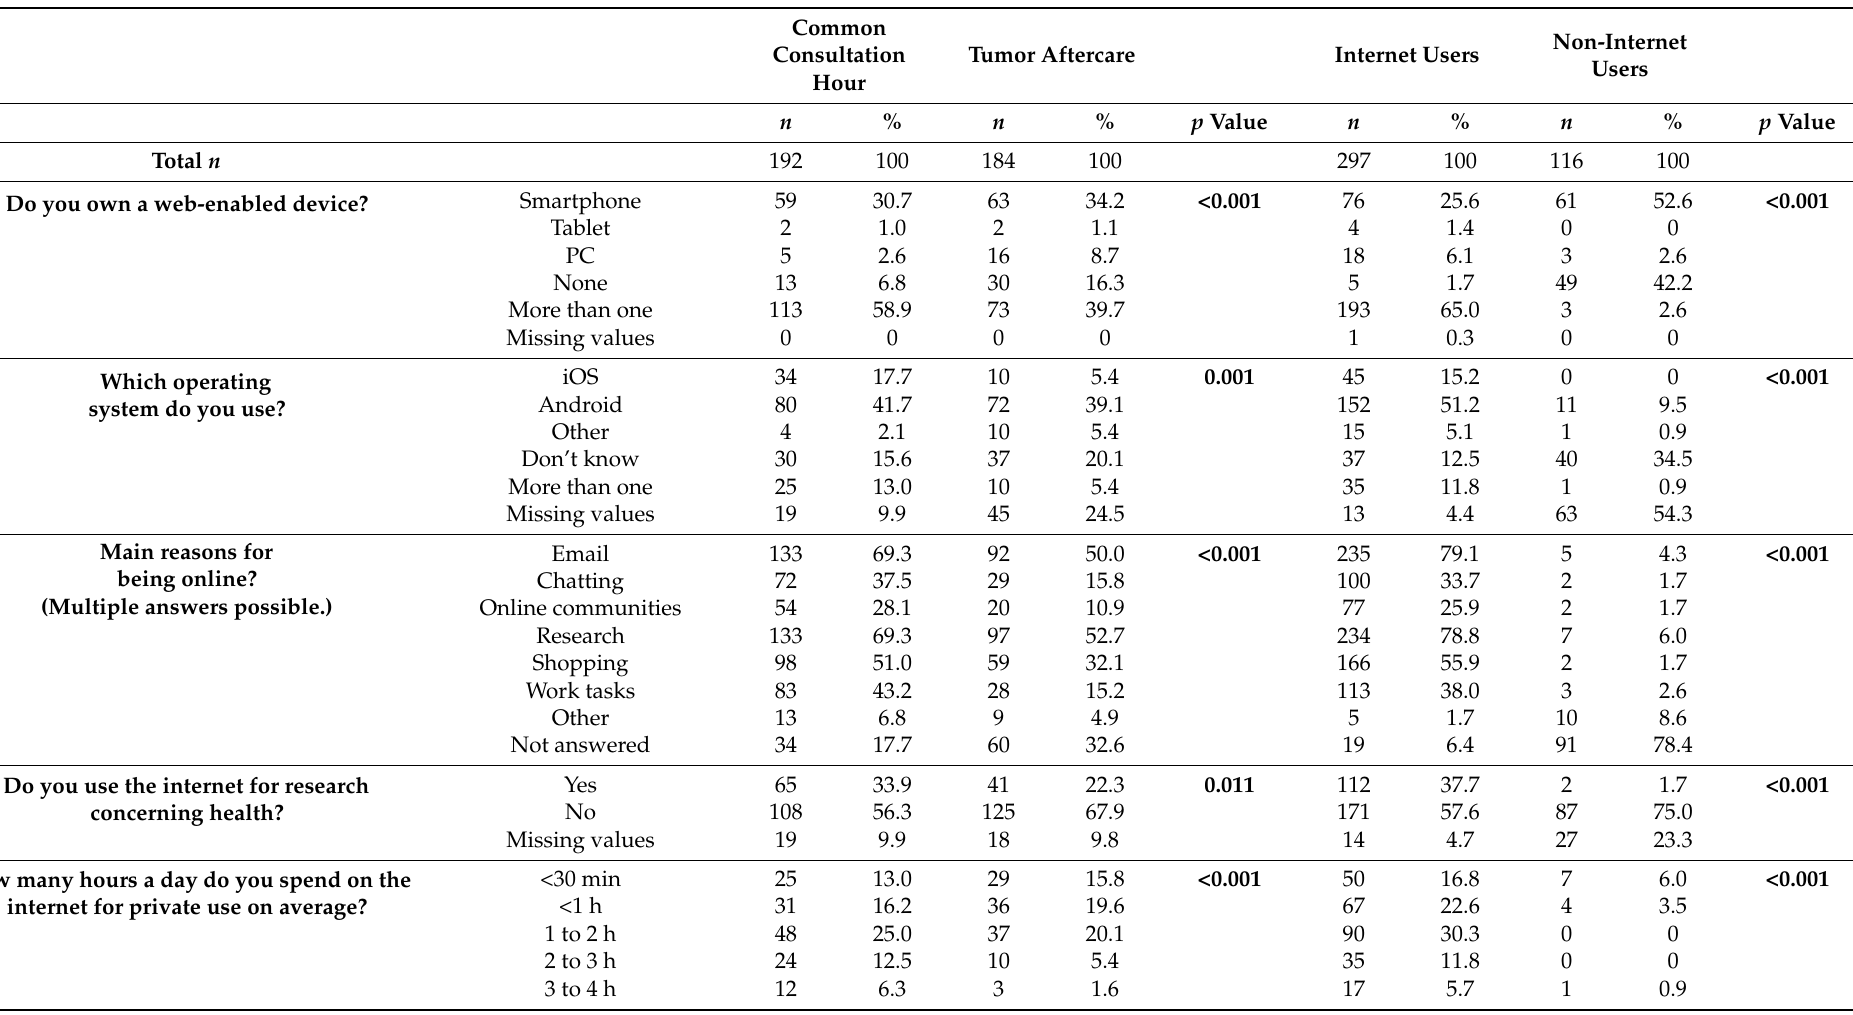
Table 2. Evaluation of internet access and internet use of ENT patients stratified according to reason for consultation (common consultation hour vs. tumor aftercare) and internet use (yes vs.